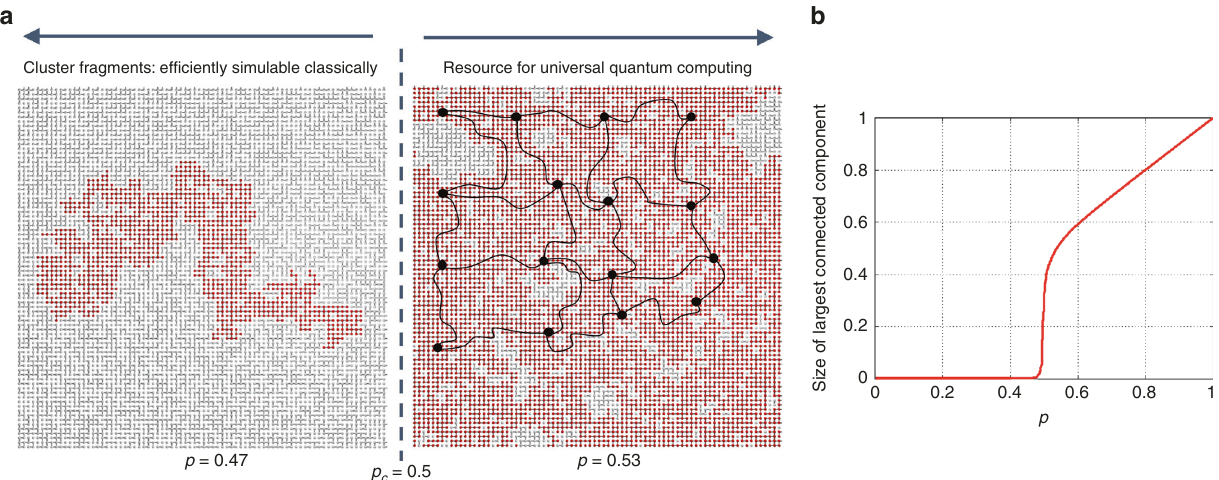
Fig. 2 Bond-percolation threshold of a square lattice. a Each bond in a regular lattice of m bonds is activated with probability p . If p < p c (the subcritical regime), where p c is the bond-percolation threshold, the size of the largest connected component is O (log m ). At p = p c , a sharp transition occurs, and for 1 ≥ p > p c , the size of the largest connected component is O ( m ). In this (supercritical) regime, O ( m ) criss-crossing edge-disjoint paths (percolation highways) exist from left to right and from top to bottom 17 , using which one can identify a logical lattice whose nodes are the intersection points of the highways, and edges are paths connecting those nodes. b Size of the largest connected component, expressed as a fraction of m , as a function of p ∈ [0,